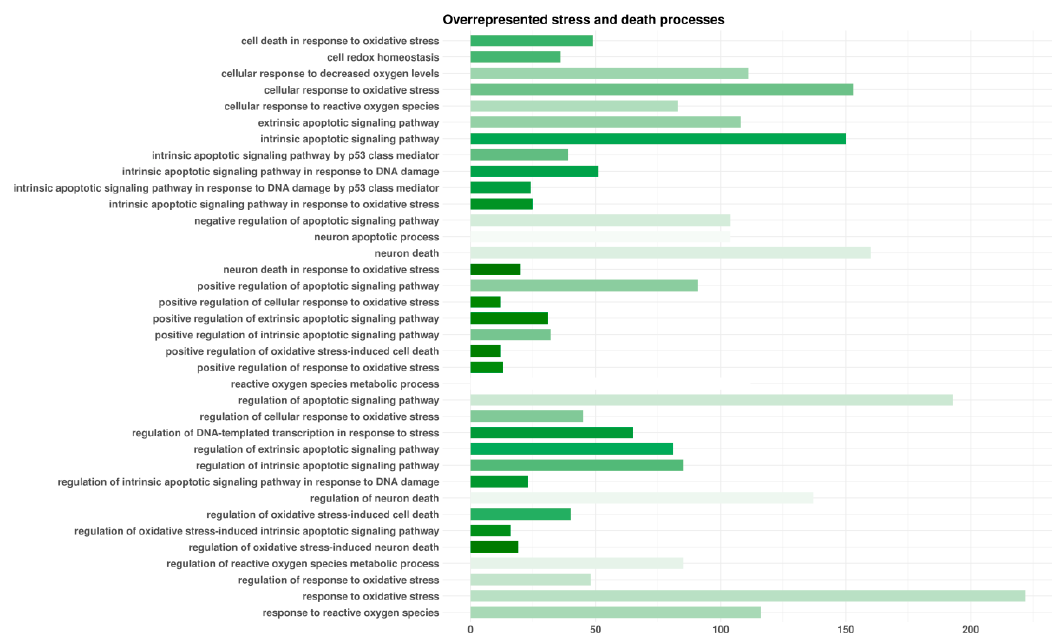
Figure 1. Enriched biological processes terms involved in oxidative stress and death by differentially expressed genes (DEGs) found in HCN-2 cells after exposure to SARS-CoV-2. For each Gene Ontology term represented, the length of the bar shows the number of DEGs observed in that specific category. The color of the bar points to the ratio between the number of DEGs found in our analysis and the number of genes included in the term from white (no DEGs of the term) to green (all DEGs of the term). The terms are alphabetically sorted.